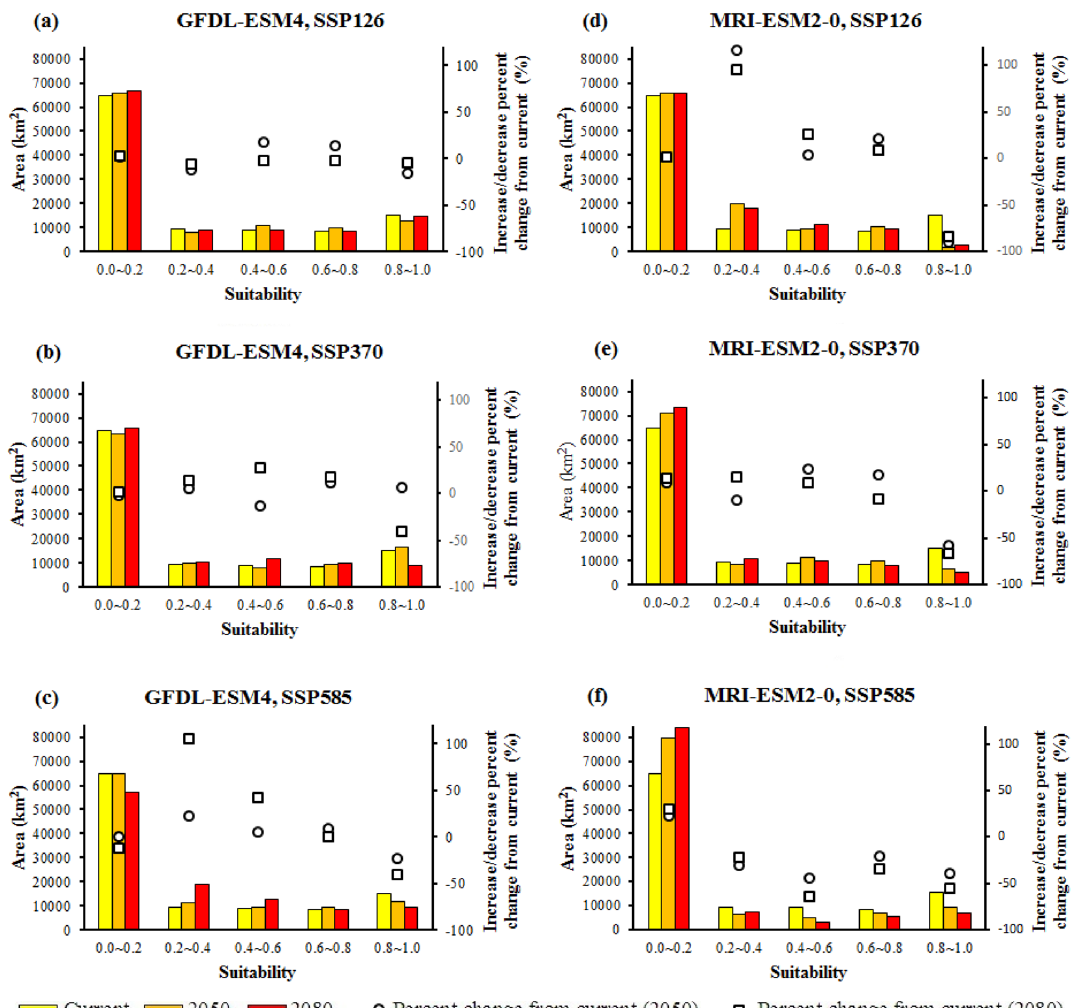
Figure 5. Projected suitable habitat for S. inflata under current and future climate change conditions (The percent change from current shows the proportion change from the current area in each suitability group). Each part refers to a different GCM (the first GCM: a – c ; the second GCM: d – f ) and different emissions